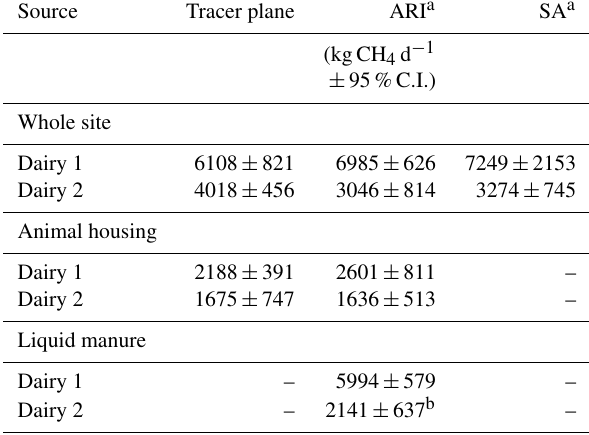
2. Comparison of methane emission estimates (kgd − 1 ± 95%C.I.) for two dairy farms between this paper (“tracer plane”) and established tracer release (“ARI”) and mass balance (“SA”) methods.